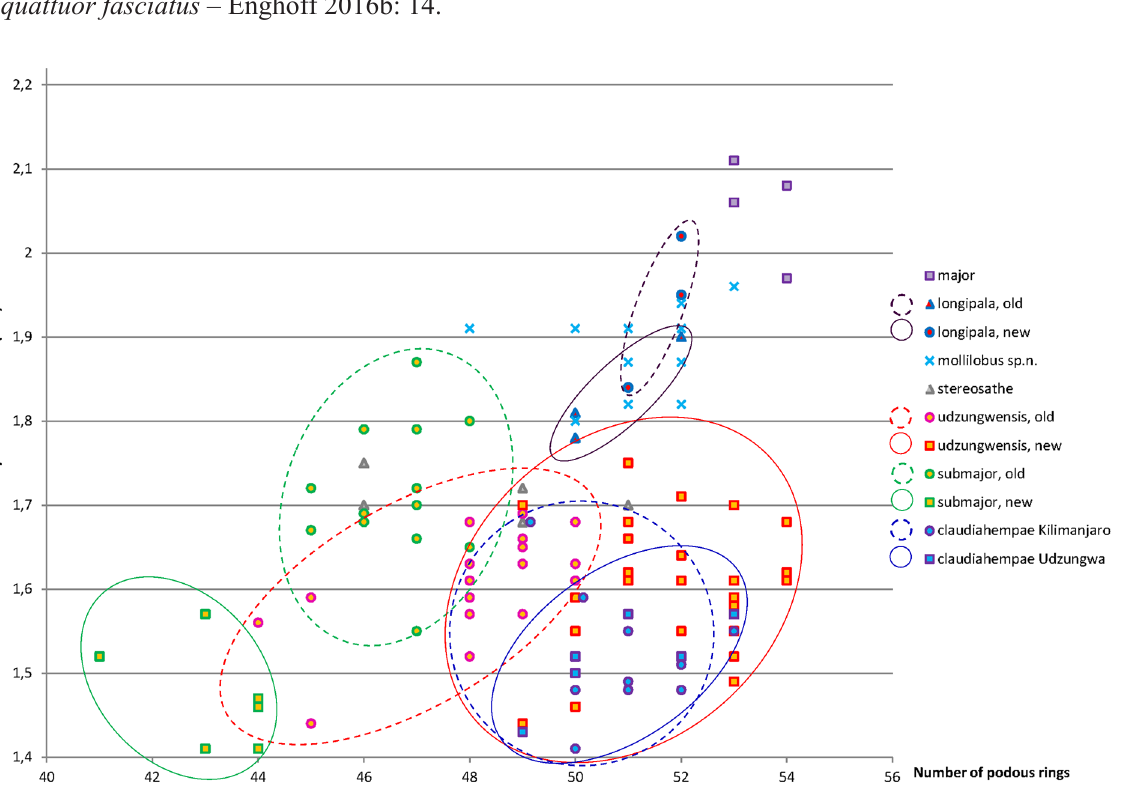
Fig. 9. Aquattuor spp. Body size (number of podous rings and midbody vertical diameter) in males of Aquattuor species from the Udzungwa Mts, and of A. claudiahempae Enghoff & Frederiksen, 2015 from Mt Kilimanjaro. In case of (almost) coinciding values, symbols have been slightly displaced